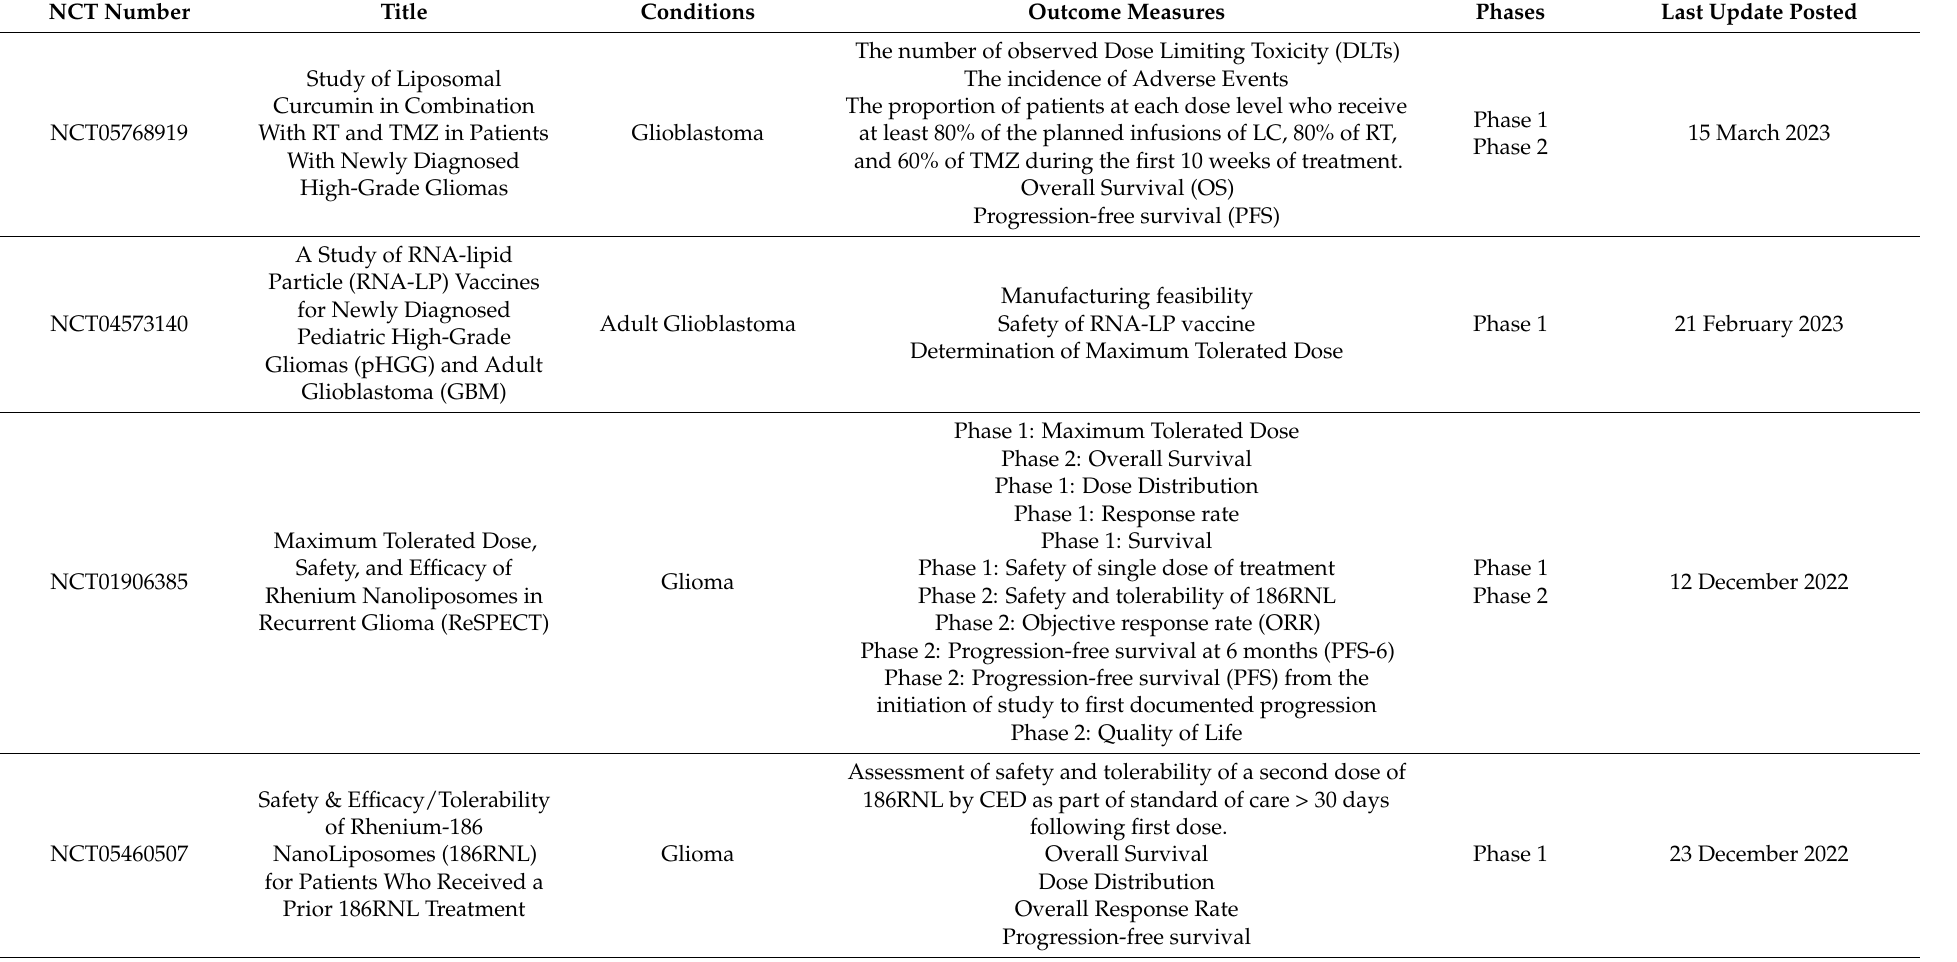
Table 2. The ongoing clinical trials of nanocarriers for the treatment of glioblastoma multiforme [217]. NCT Number